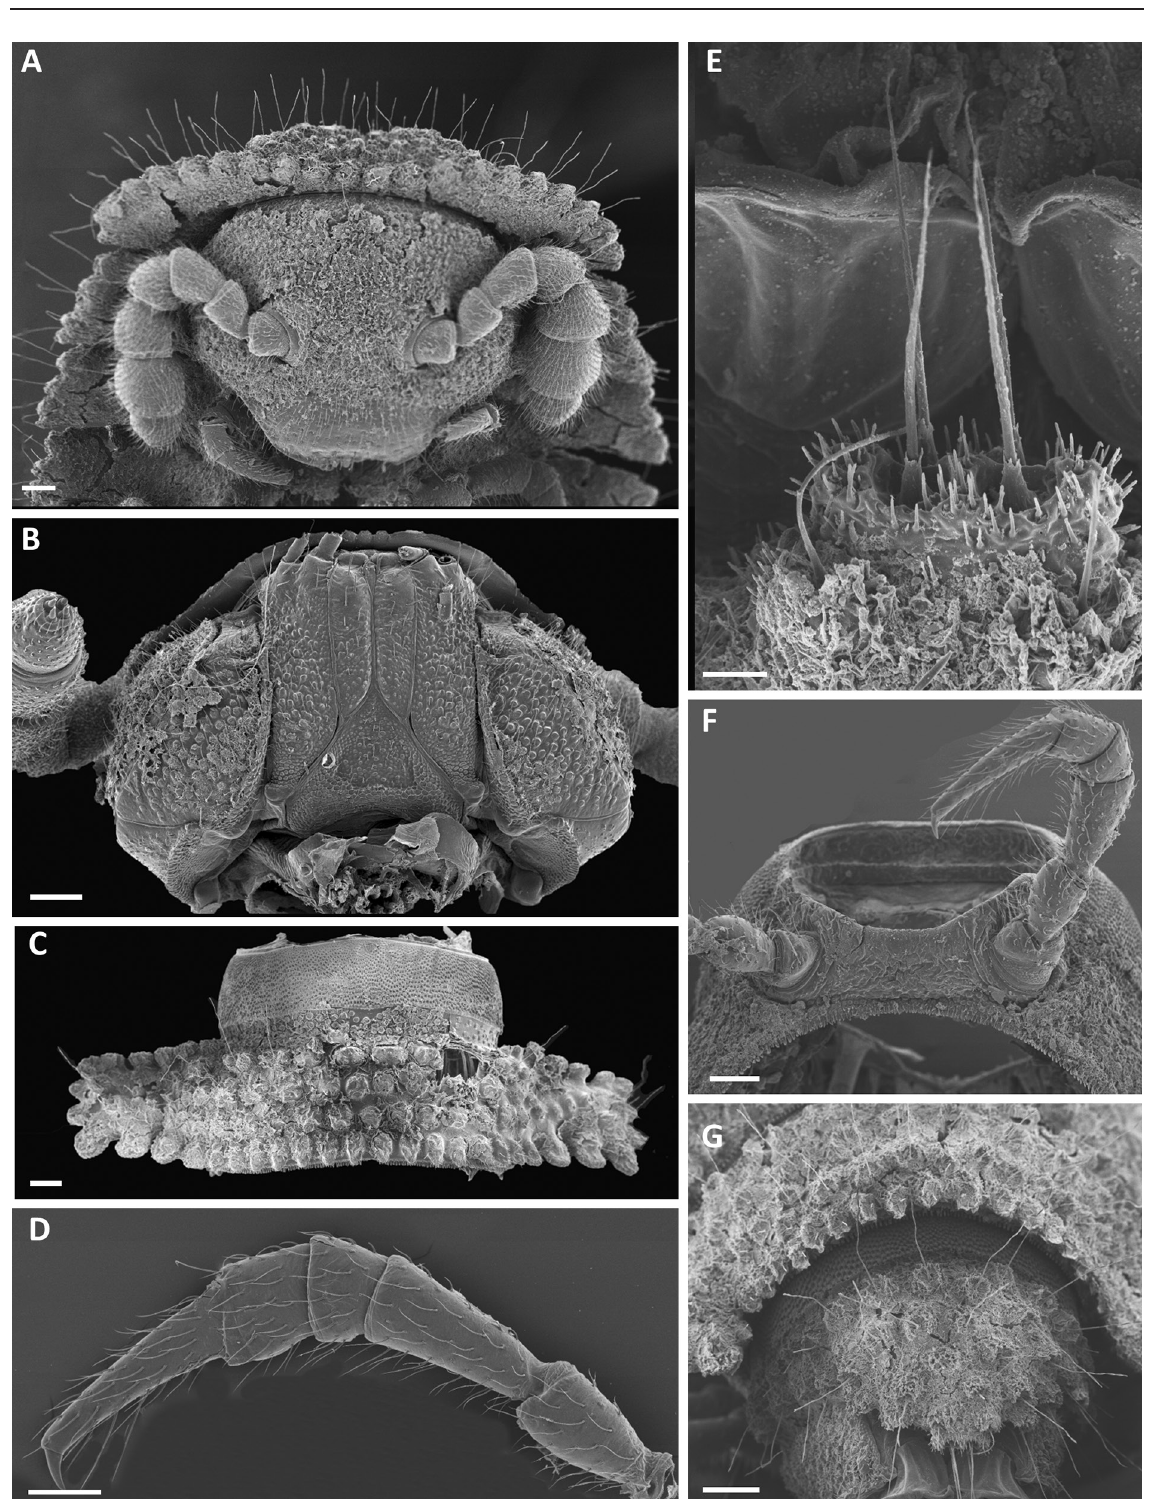
Fig. 13. Elythesmus enghoffi Hoffman, 1978, ♂♂, from Kidatu. A, E–G . ♂ (NHMD 621778). B–D . ♂ (NHMD 621779). A . Head and collum, frontal view. B . Gnathochilarium and mandibles, ventral view. C . Ring 9, treated with ultrasound. D . Midbody leg. E . Spinnerets on telson. F . Gonopodal aperture, posterior-ventral view. G. Apodous ring and telson, posterior view. Scale bars: A–D, F–G = 0.1 mm; E = 0.02